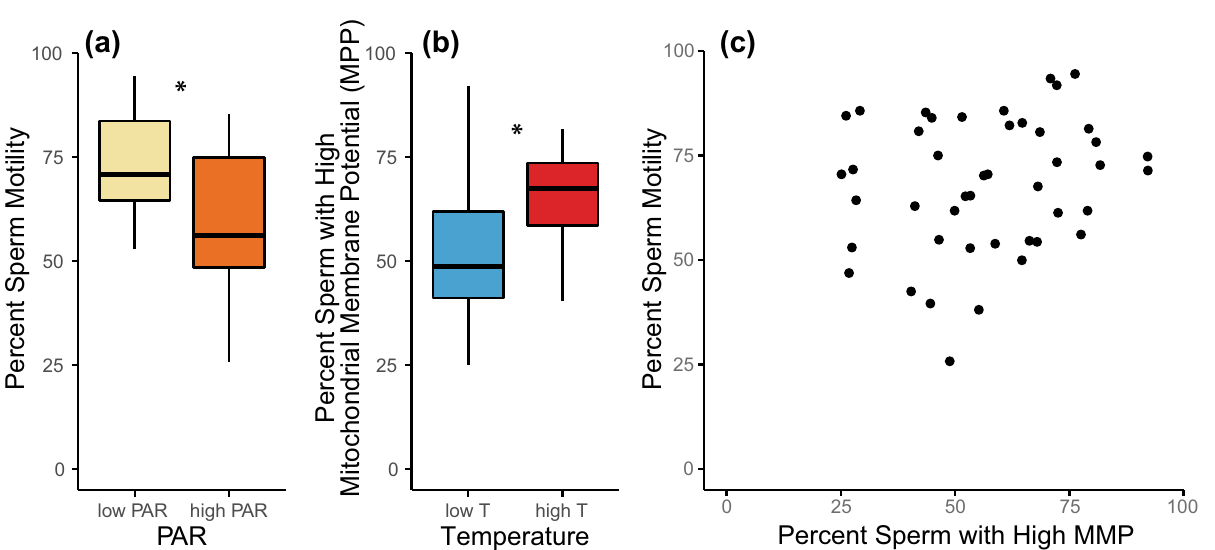
Figure 5. Sperm physiology was affected by PAR and temperature. Sperm motility ( a ) was sensitive to PAR and was lower at ambient PAR levels. Mitochondrial membrane potential ( b ) was sensitive to temperature and was lower at low temperature levels. A star * means that the treatments were significantly different from each other. ( c ) There was no significant correlation between percent sperm with high mitochondrial membrane potential and percent sperm motility (p =